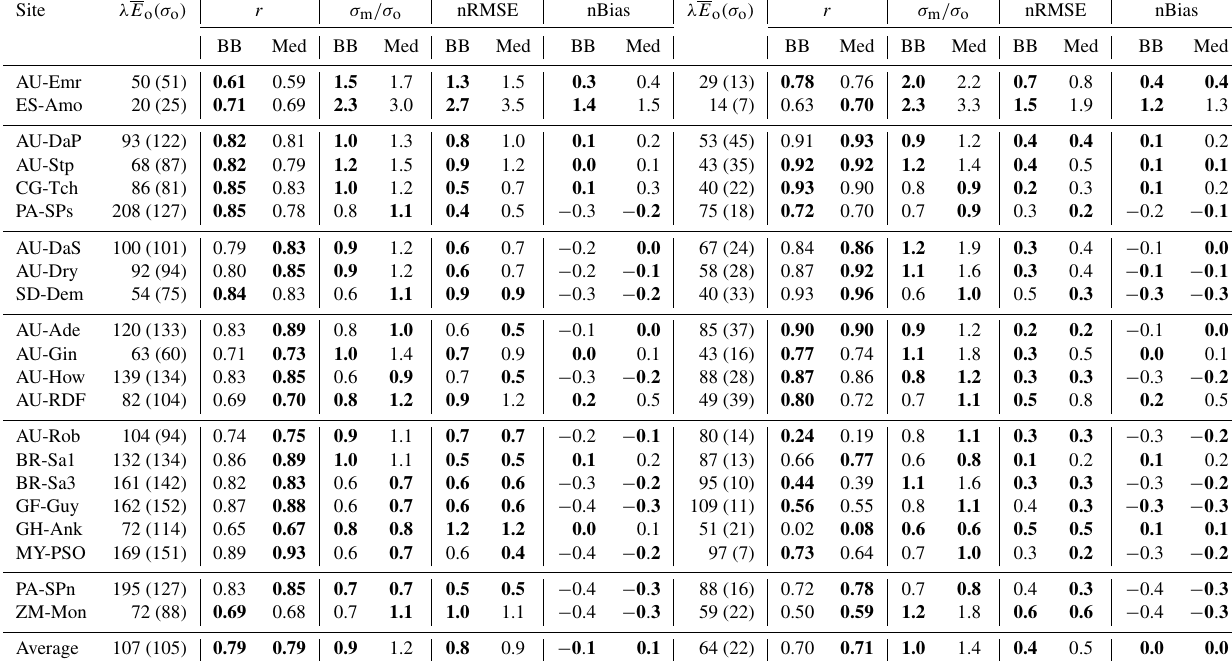
Table 7. Model performance statistics for simulated hourly (left) and monthly (right) latent heat fluxes for the CLM/BB and CLM/Med simulations. Bold fonts indicate the model configuration that performed better. The mean and standard deviation of the observed fluxes ( λE o and σ o , respectively), shown for reference, are given in Wm − 2 . The RMSE and bias have been normalized by the mean of the observed fluxes for easier cross-site comparison.